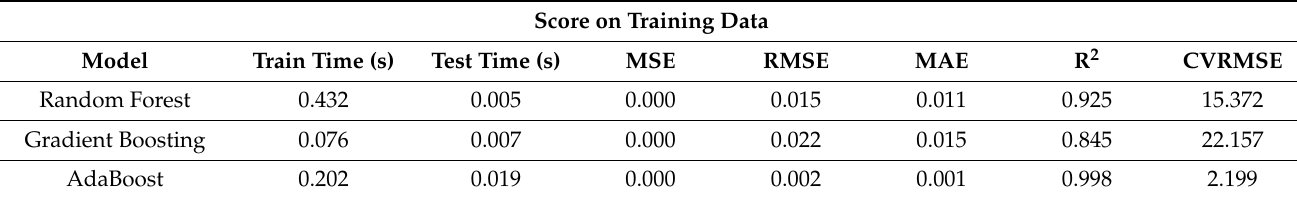
Table 5. Score in training data.